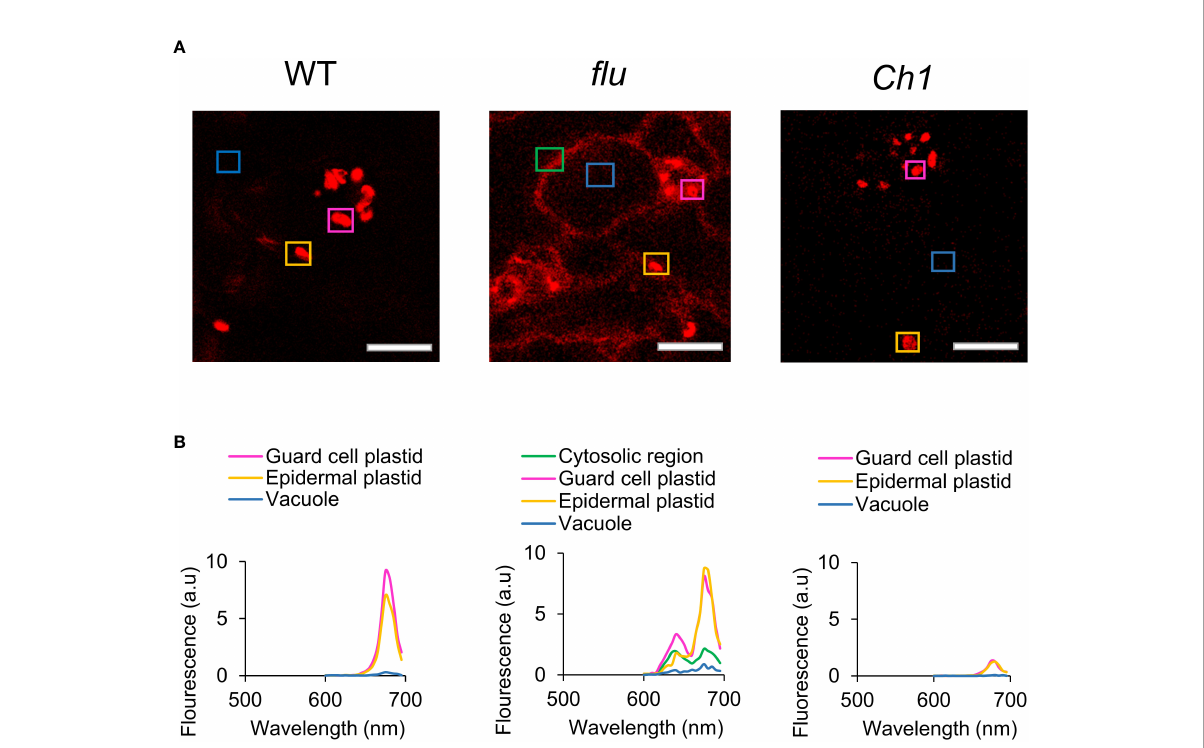
FIGURE 2 Comparison of chlorophyll fl uorescence and localization in WT, fl u and Ch1 seedlings under dark incubation. (A) Spectral imaging of WT, fl u or Ch1 seedlings during dark incubation. WT, fl u or Ch1 seedlings were incubated in the dark for 4 h, then mounted in DDW for imaging as described in the Methods. Scale bar represents 5 µm. (B) Spectral analysis of chlorophyll fl uorescence. Areas indicated by boxes in (A) were analyzed and the emission spectrum was